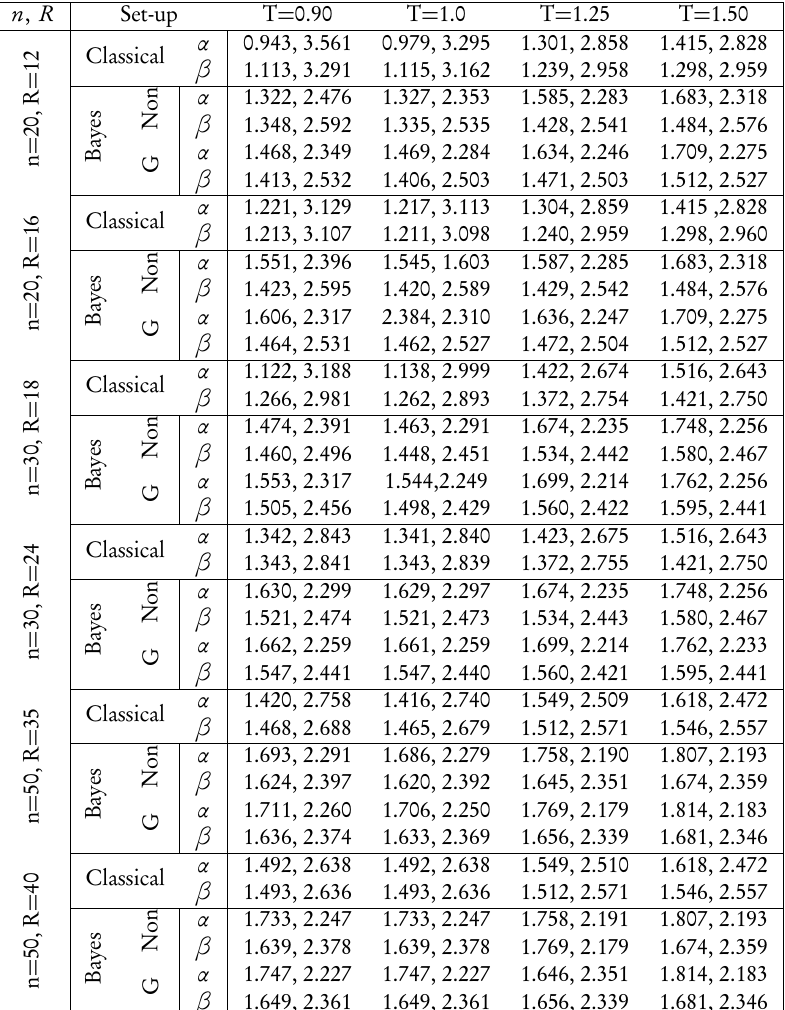
Average confidence / HPD intervals of α and β from different hybrid Type-II censoring scheme for fixed values of α = 2, β = 2